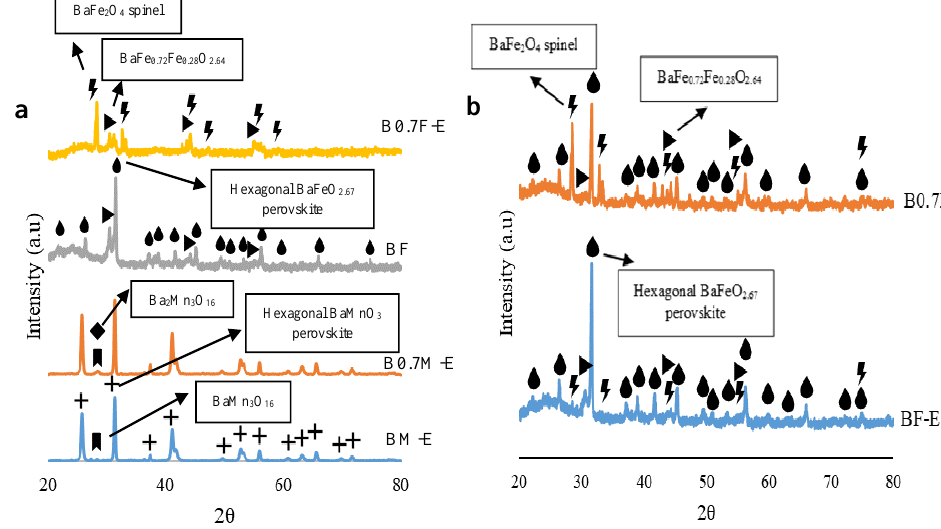
Figure 1. XRD patterns of ( a ) BM-E, B0.7M-E, BF, and B0.7F-E; and ( b ) BF-E and B0.7F catalysts. Table 1. XRD data for BM-E, B0.7M-E, BF, and B0.7F-E catalysts. Catalyst